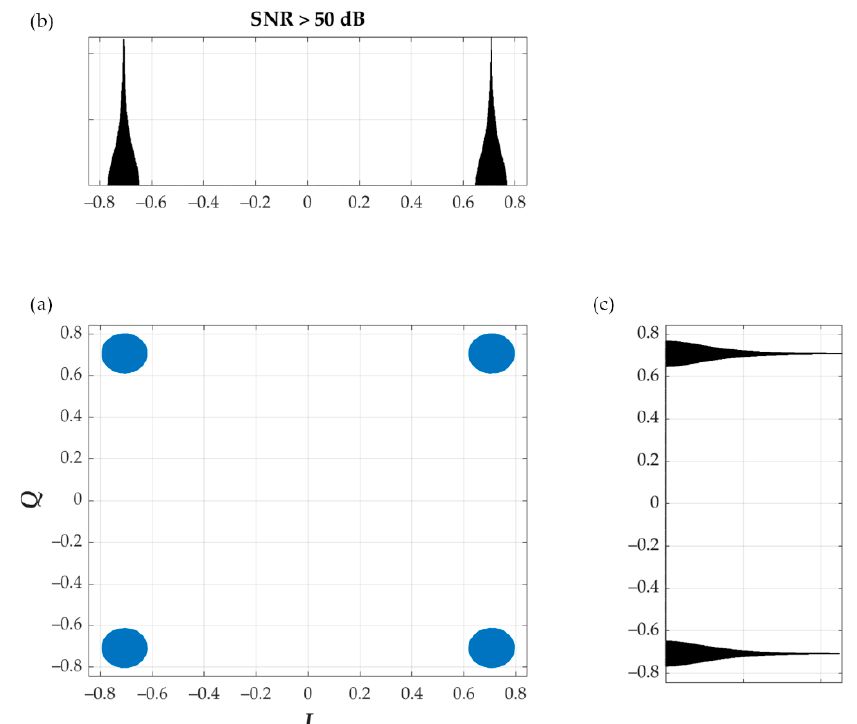
Figure 15 . ( a ) Constellation, ( b ) in-phase and ( c ) quadrature histogram for SNR > 50 dB, K = 30, random A m , and EVM = 3%.